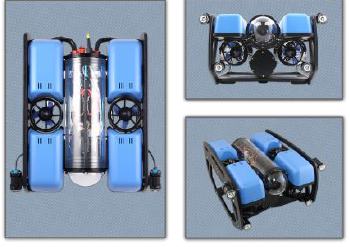
Figure 6. BlueROV2 - The underwater vehicle for